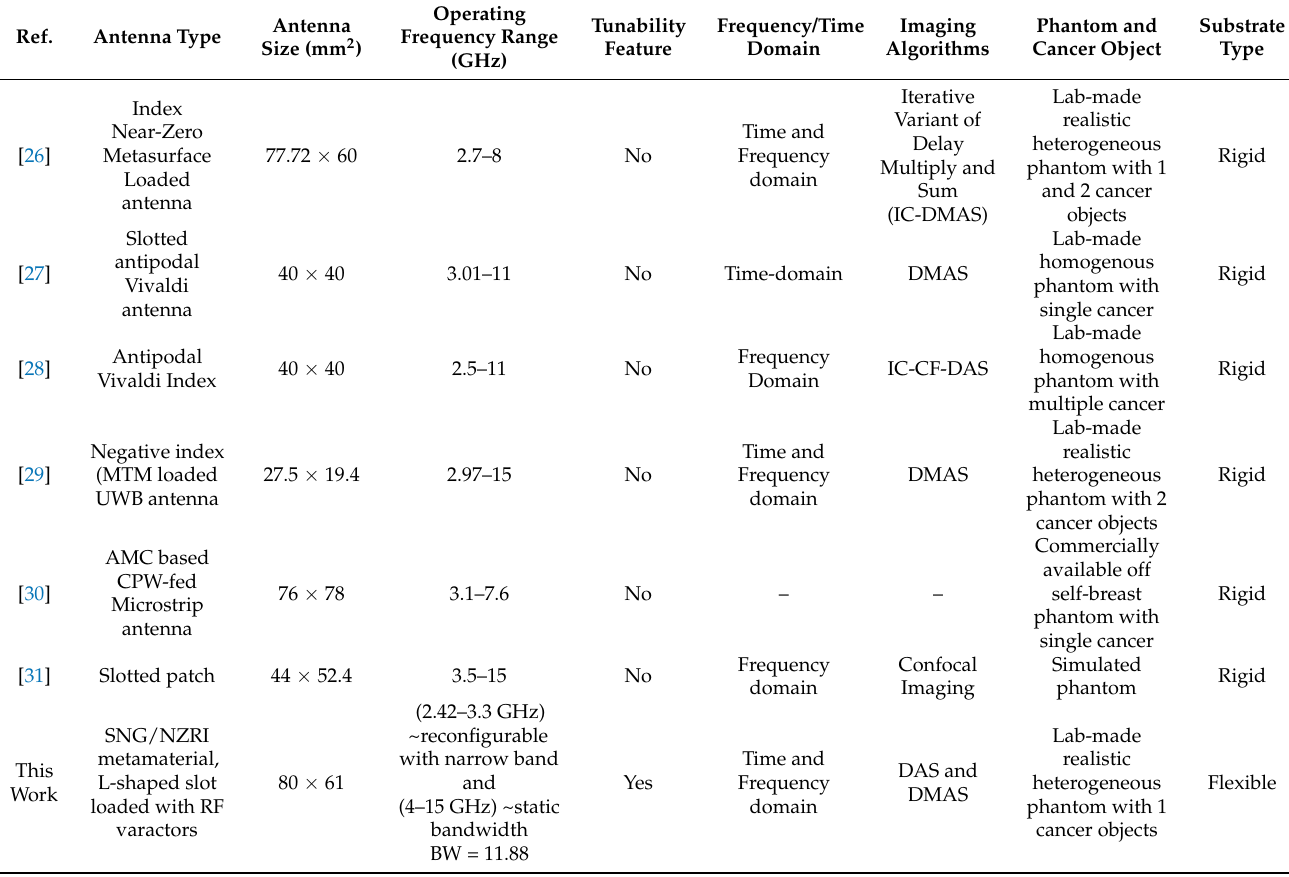
Table 1. Comparison of MTM-based UWB antenna for breast cancer detection